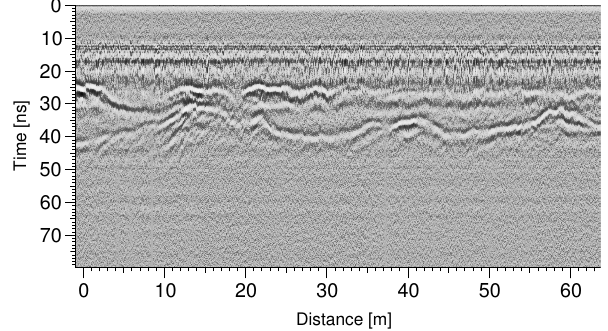
Fig. 2. Schematic of a four channel GPR setup.